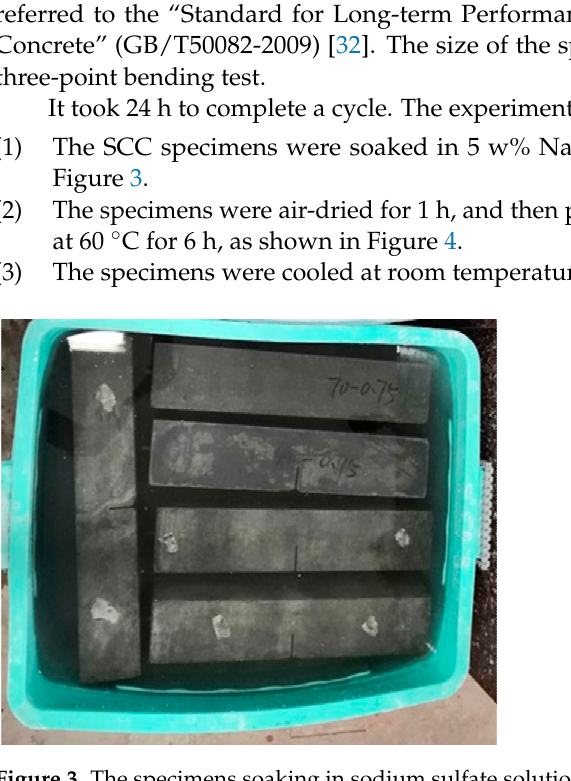
Figure 2. The three-point bending test process.